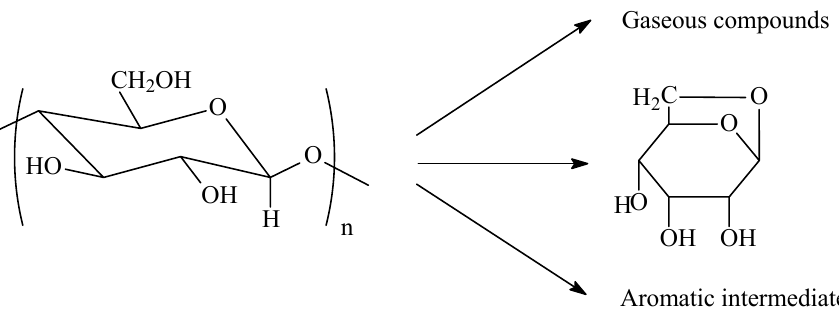
Figure 6. Thermal decomposition of